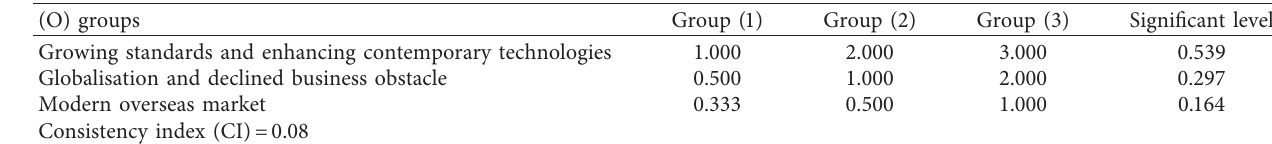
Table 7: Analogy matrix of (O) group.